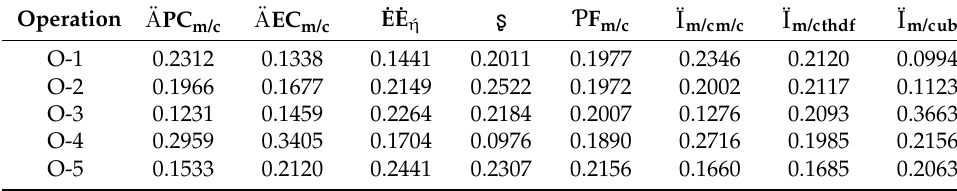
Table A2. Probability of responses (entropy method).